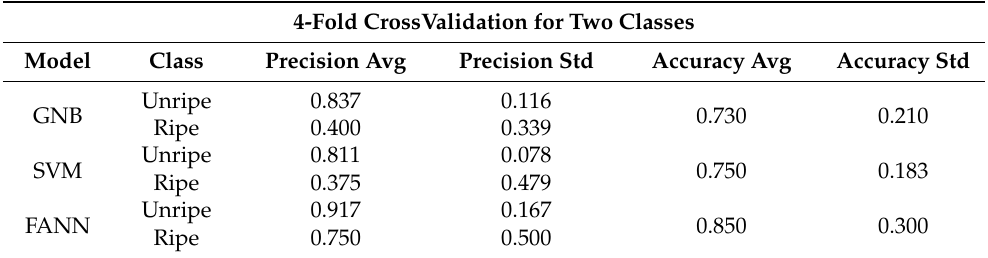
Table 7. Performance of three ML models for two-class classification using original data.